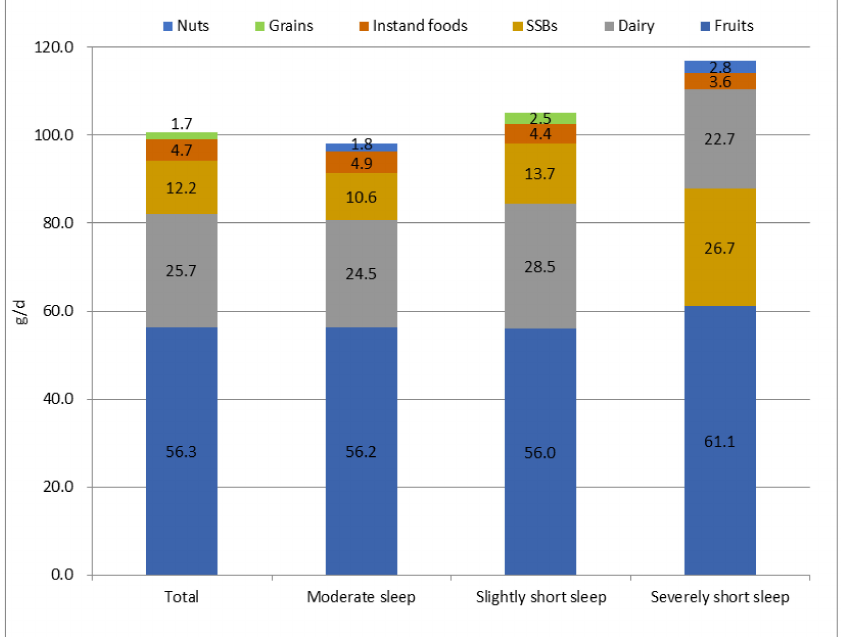
Figure 3. The top 5 snack types with highest daily intake at night in children with different sleep